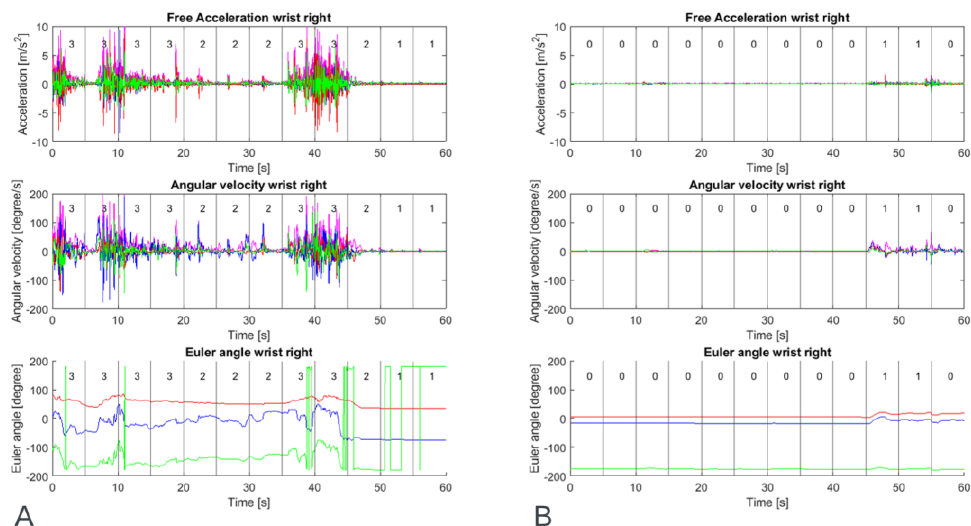
Figure 3. Example of data of one participant’s right wrist during a resting activity showing inertial sensor output: free acceleration, angular velocity and Euler angle, ( A ) with a high level of dystonia and ( B ) with a low level of dystonia. The number within the time windows of 5 s is the median clinical score of three raters for upper extremity dystonia of the right wrist. Table 2. Overview of the 10 feature classes passed the feature selection